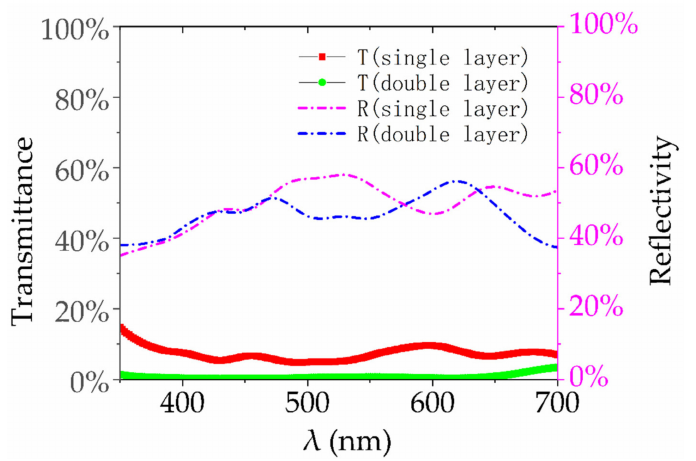
Figure 13. Transmittance and reflectance curves of Ag NPs for single layer and double layer. Reflec- tivity and transmittance show that most of the light is reflected and scattered by the first layer. The transmittance of single layer is about 10%, and that of double layer is about